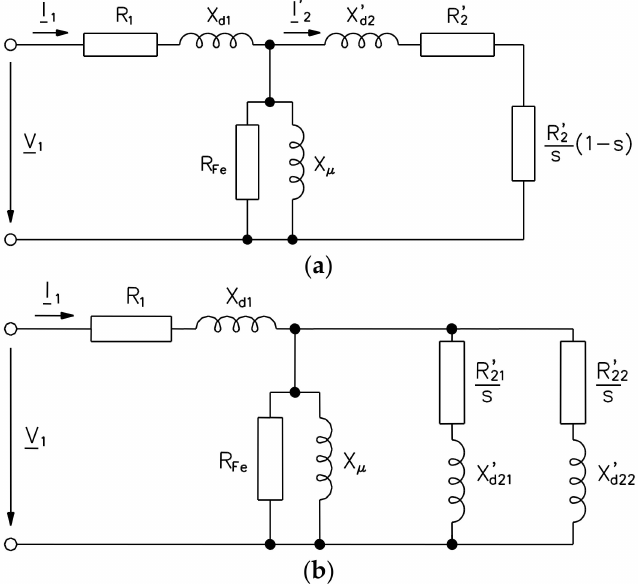
Figure 1. Equivalent circuits for induction motors. ( a ) Single cage, ( b ) Double cage.